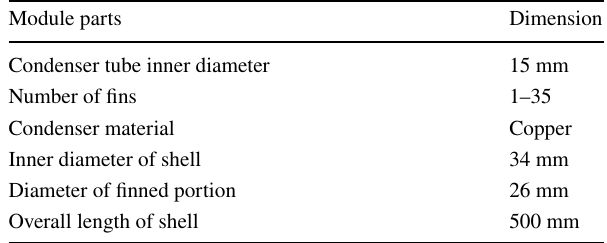
Table 1 Dimensions of HAGMD system